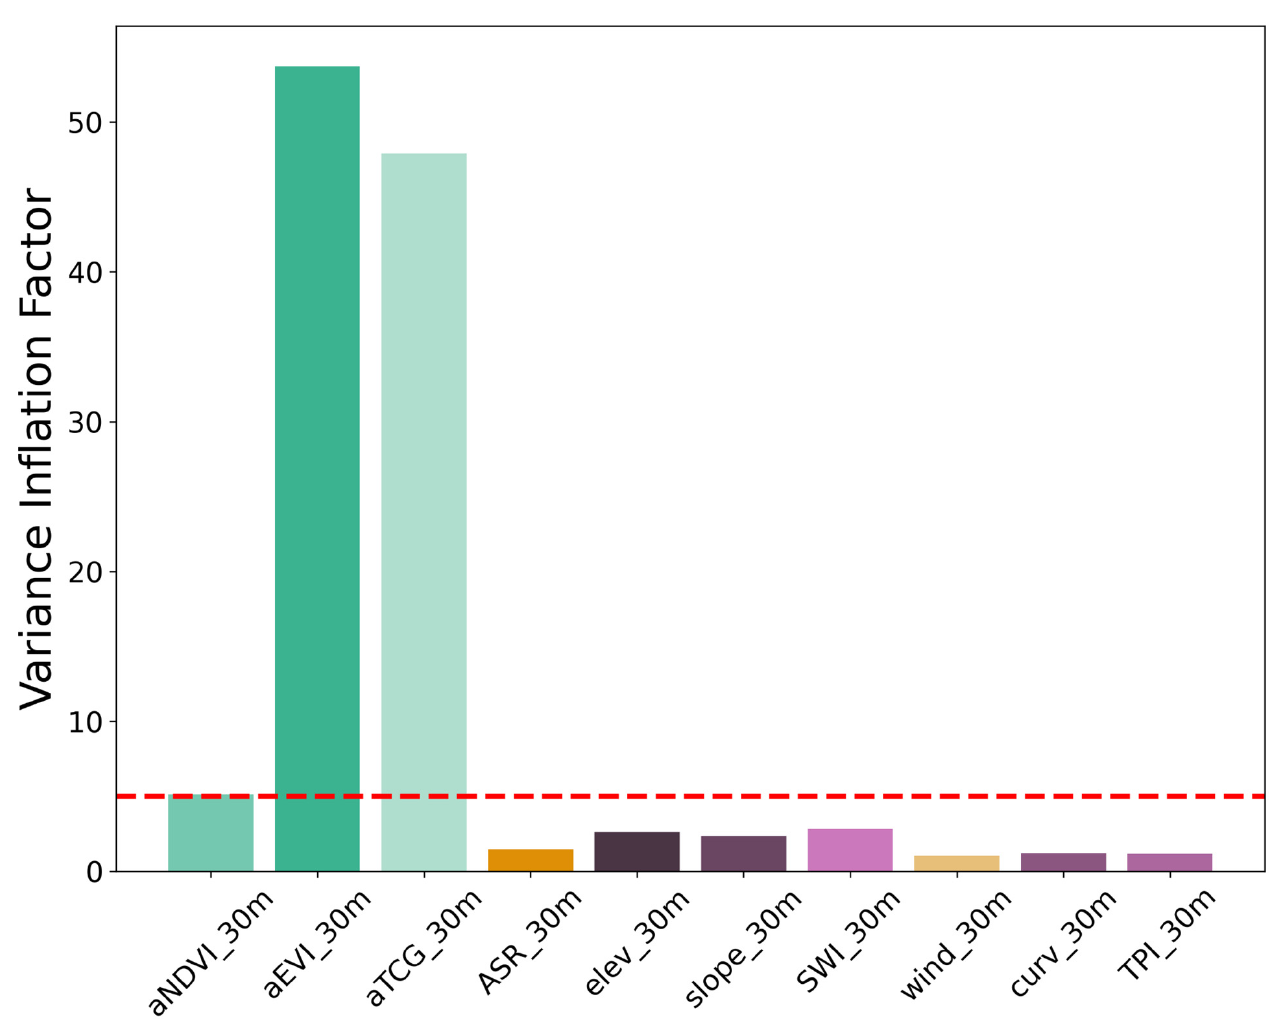
Figure A3. Variance inflation factors for the ten predictor features at their smallest resolutions. The red dashed line shows the accepted threshold of five [80].